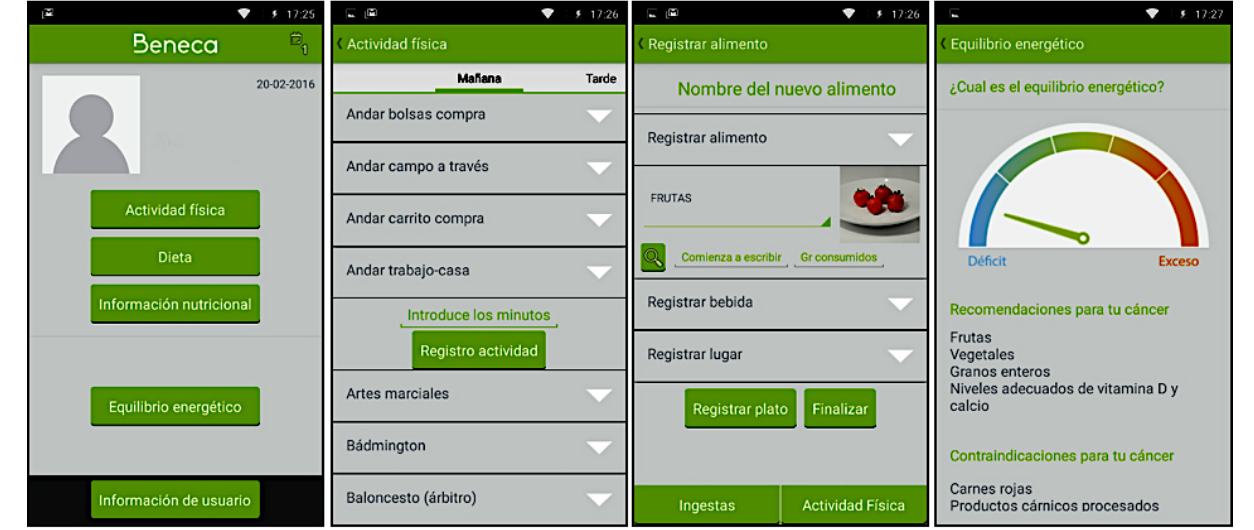
Figure 1. Screenshots of the Energy Balance on Cancer (BENECA) mobile health